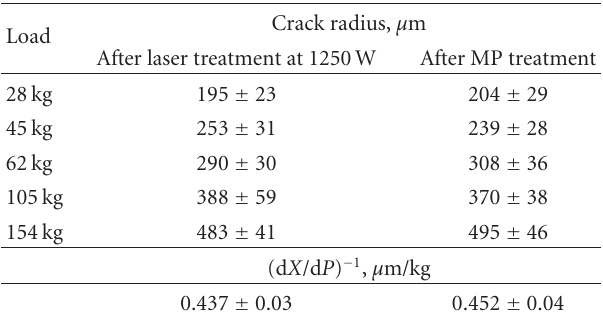
Table 3: Cracks radius on diamond coatings after laser (1250W) and MP